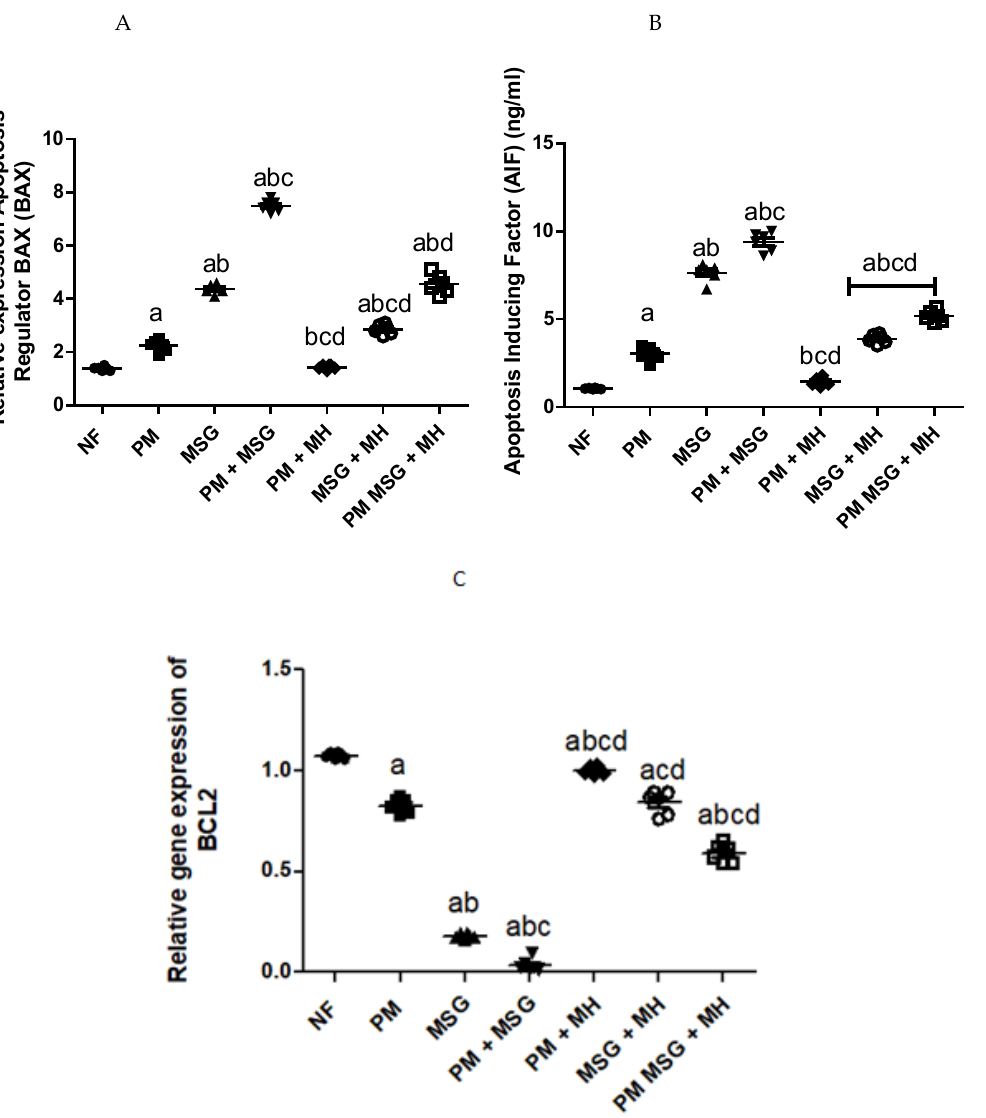
Figure 10. MH improve apoptotic/anti-apoptotic markers of PM and/or MSG—fed rat pups. Effect of 60 mg/kg MH combined with PM diet and/or 0.4 g/kg MSG on brain activity of: Bax ( A ); AIF ( B ); and Bcl-2 ( C ) as apoptosis related markers in rats. Data presented as mean ± SEM ( n = 6). a–d depicts significant difference compared to NF, PM, MSG, PM + MSG groups, respectively, at p < 0.05. Statistical analysis was performed using one-way ANOVA, followed by Tukey’s post hoc test. [The data of the effect of MH on the control NF is not shown as it is not significant].